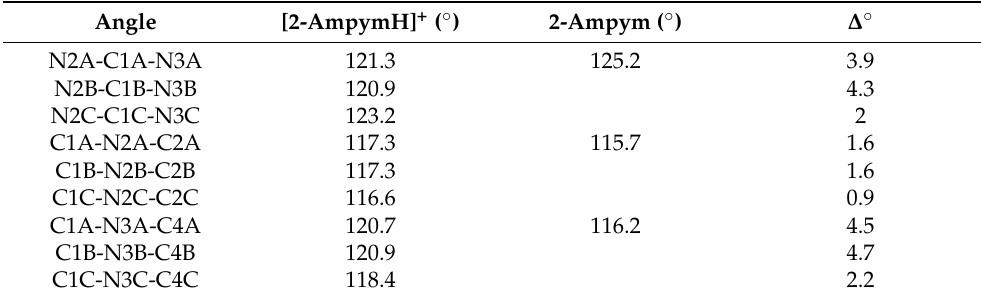
Table 2. Difference between the angles ( ∆ ◦ ) of the neutral 2-ampym molecule and the cations A, B, and C of the protonated ligand in Compound 1